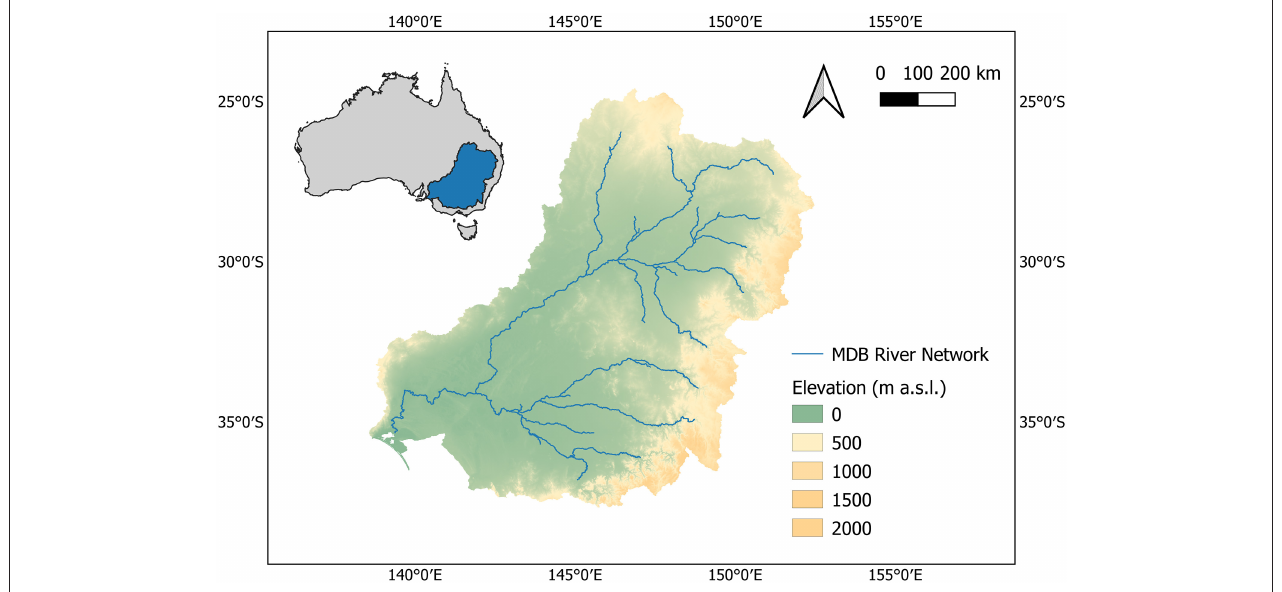
FIGURE 2 | Study area: Location of the Murray Darling Basin, main river network and